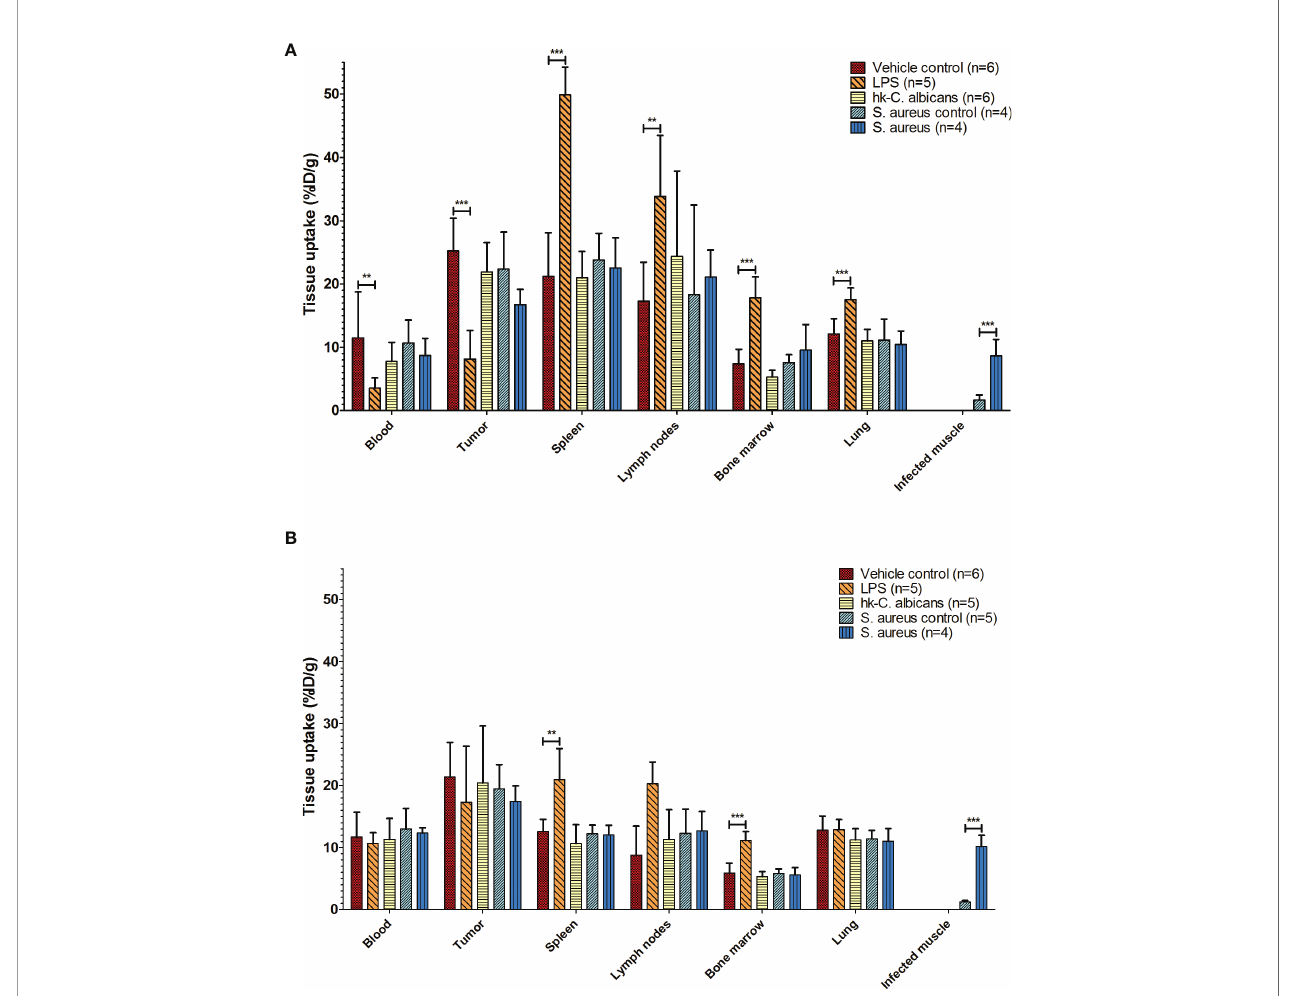
FIGURE 2 | Biodistribution of 111 In-mPD-L1 in different infection models. Ex vivo biodistribution of 30 µg and 100 µg of 111 In-mPD-L1 antibody doses in RenCa tumor-bearing BALB/c mice injected with vehicle control or immune stimulated with LPS, Hk- C. albicans , or Staphylococcus aureus , at 24 h post injection. Data for tissues not shown can be found in Supplementary Table 1 . (A) In 30 µg of 111 In-mPD-L1-injected mice, immune stimulation with LPS signi fi cantly affects 111 In- mPD-L1 blood clearance, lymphoid, and tumor uptake. In S. aureus -infected muscle, signi fi cantly increased uptake of 111 In-mPD-L1 was observed. (B) For 100 µg of 111 In-mPD-L1-injected mice, LPS stimulation increased uptake in lymphoid organs, but no effect was observed on blood levels or tumor targeting. Signi fi cant uptake of 111 In-mPD-L1 can be observed in S. aureus -infected muscles. Biodistribution of neither 111 In-mPD-L1 dose was affected by Hk- C. albicans stimulation. 111 In-mPD-L1 tissue uptake is given in % injected dose per gram of tissue (%ID/g), and differences in uptake were tested for signi fi cance using two-way ANOVAs with a Bonferroni post-hoc test (**p < 0.01, and ***p < 0.001) (see legend in fi gure for number of animals per group). LPS, lipopolysaccharide; Hk- C. albicans , heat- killed Candida albicans